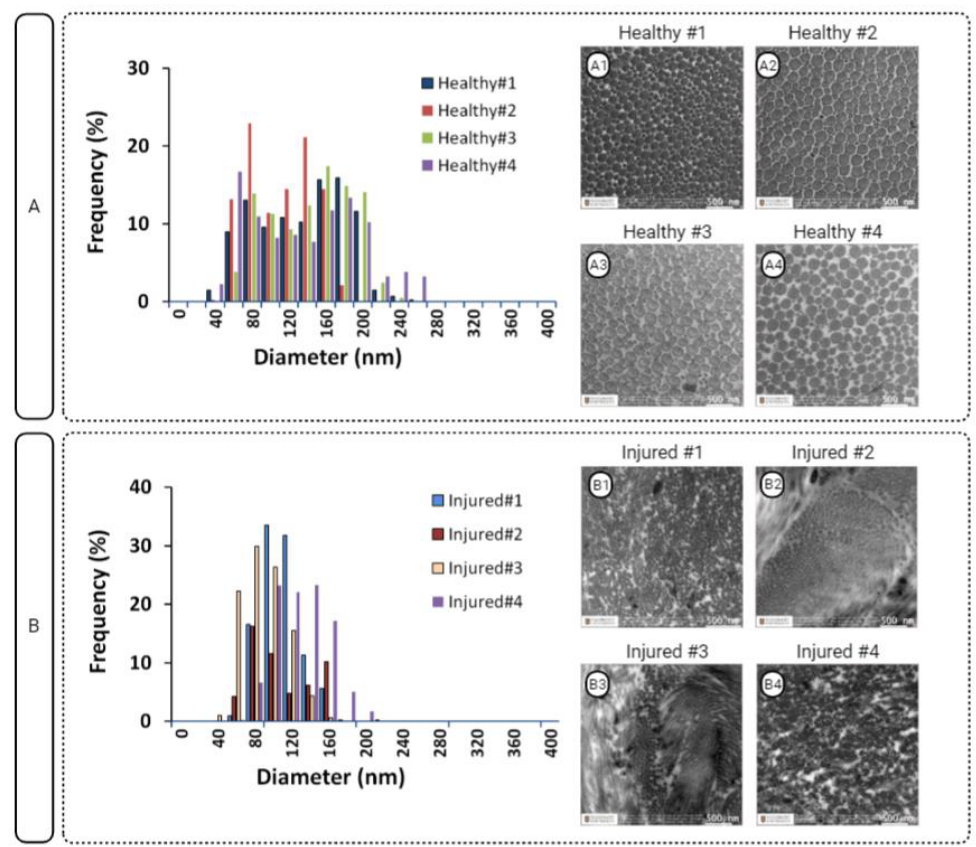
Figure 2. Diameter distribution of healthy ( A ) and injured ( B ) ACL fibrils and respective TEM images (A1 – A4 and B1 –